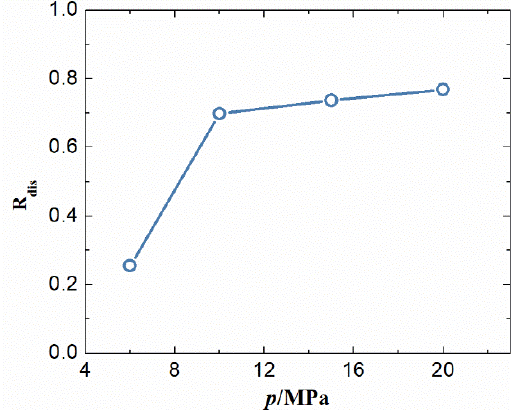
Figure 7. The displacement efficiency of CH 4 along with the injection pressure.